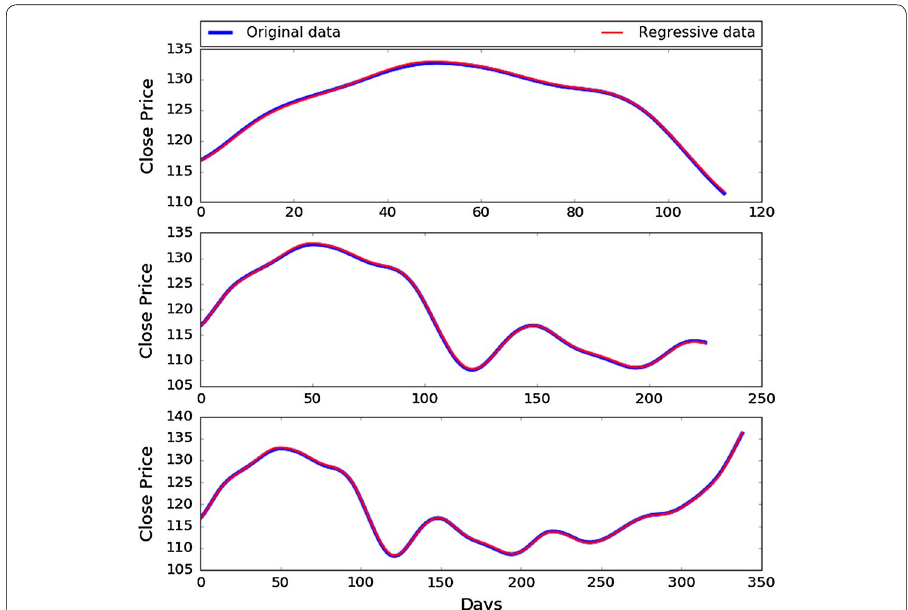
Fig. 6 Stock: IAM - Original data VS Regressive data